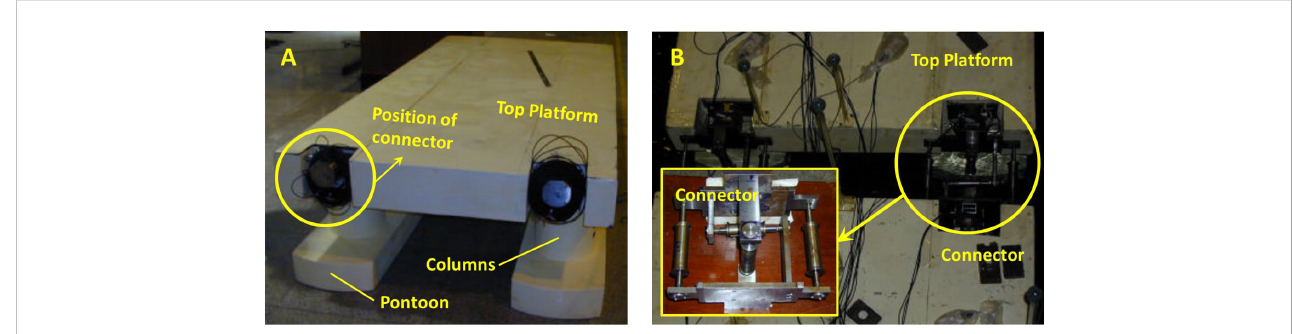
FIGURE 16 The physical model of CP-VLFS (Ding, 2004 and Yu, 2004): (A) module; (B)